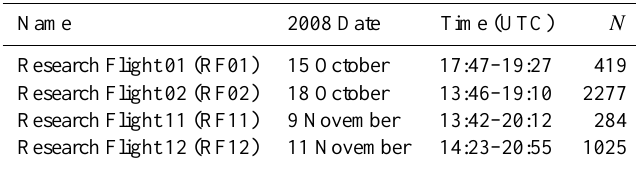
Table 1. C-130 research flights, time periods, and number of flight samples contributing to the study after thresholds were applied. Local time is approximately